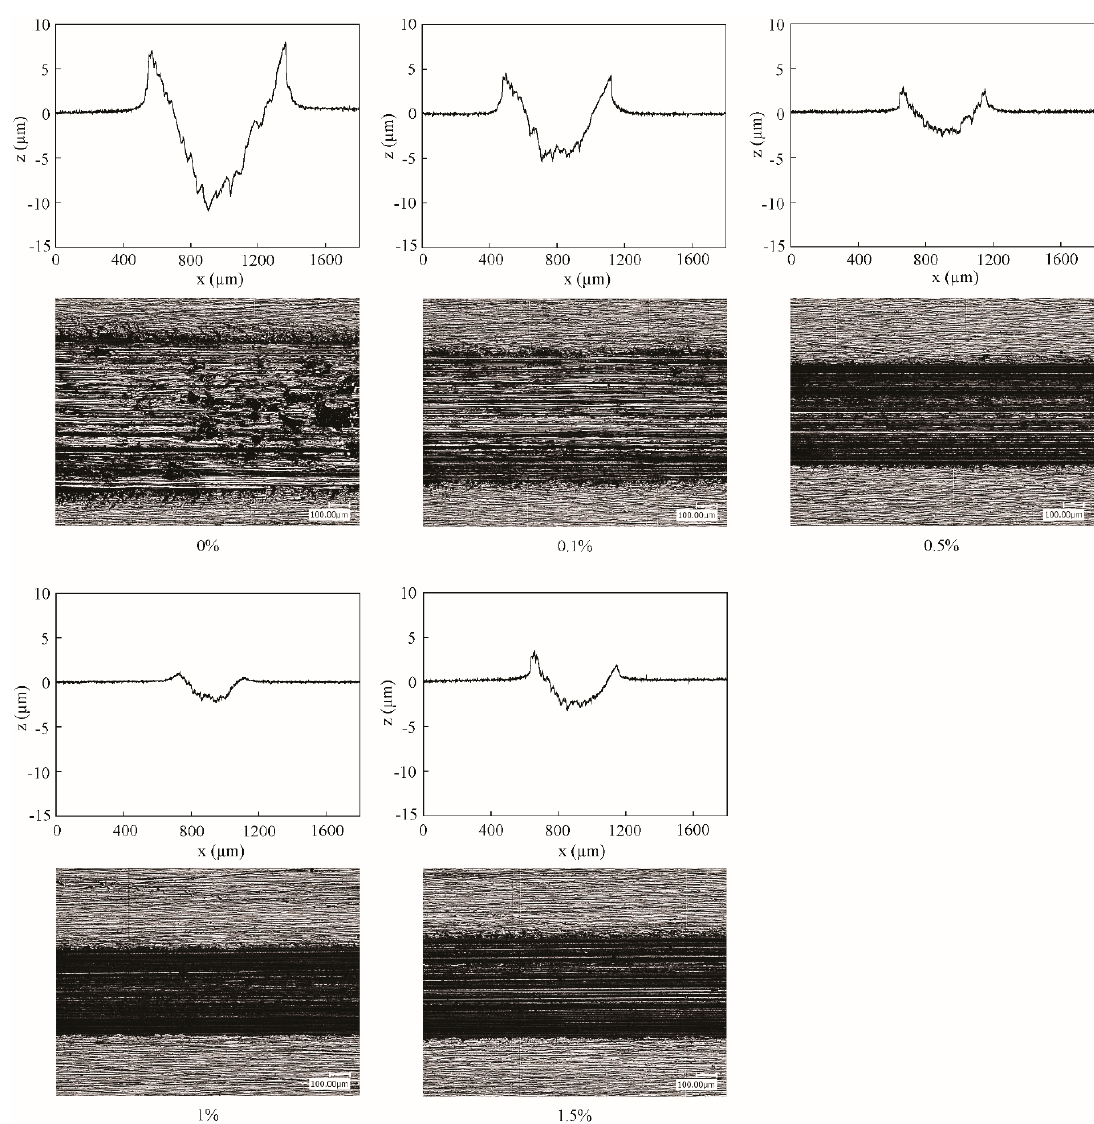
Figure 8. Two dimension (2D) profile curves and images of the wear scars lubricated by the base oil and that with different concentrations of lamellar ZrS 2 nanobelt additives. x is scan length, z is depth.